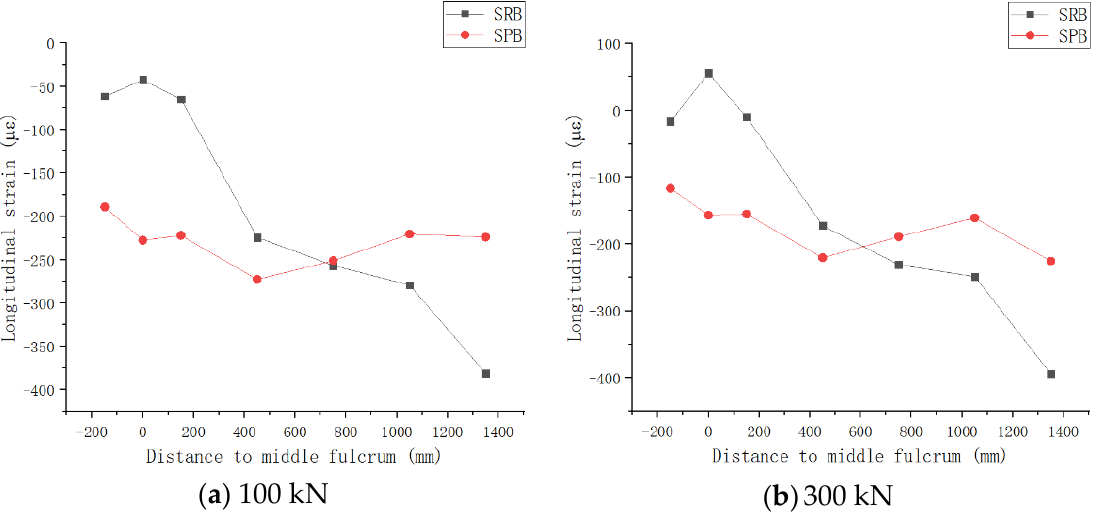
Figure 15. Longitudinal Distribution of Average Strain of Concrete Deck under Negative